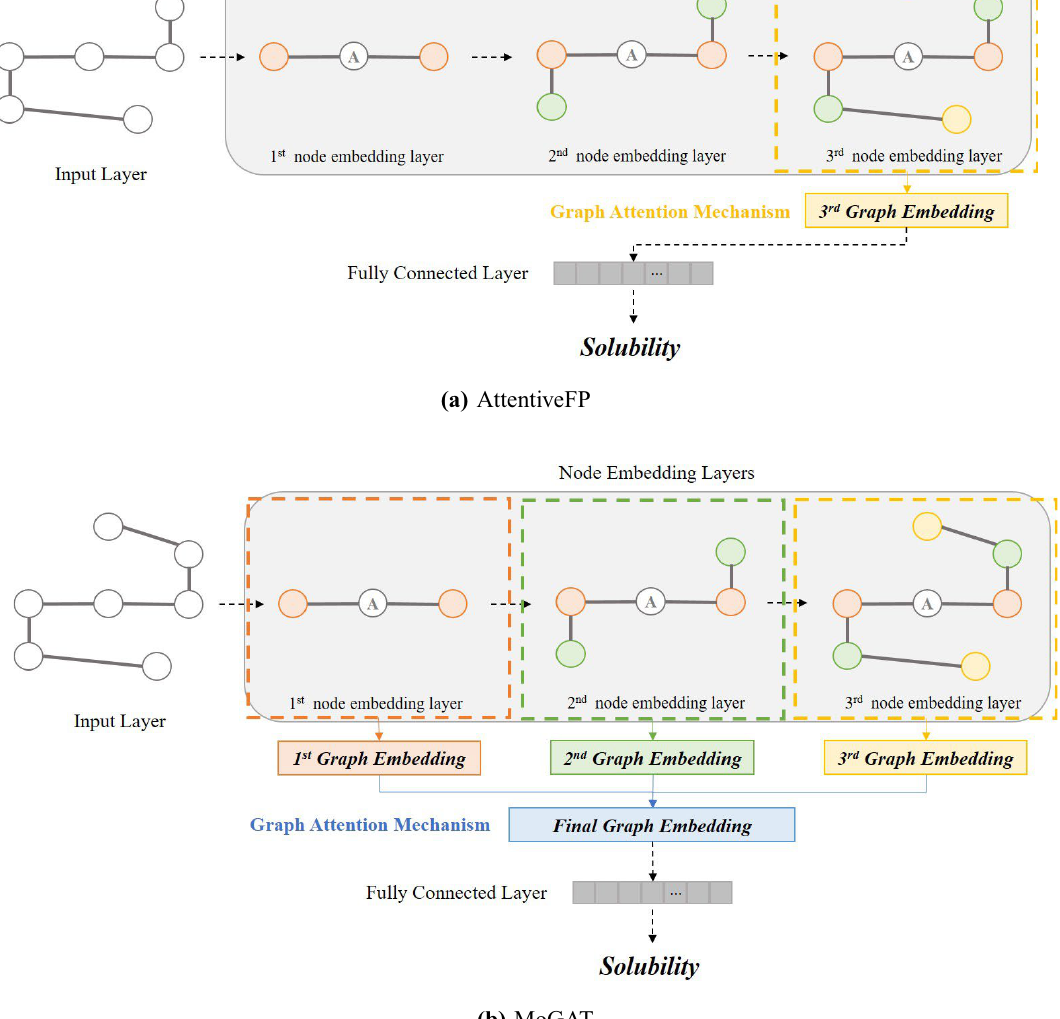
Figure 1. Overviews of ( a ) AttentiveFP and ( b ) MoGAT. The first, second, and third-order neighboring nodes are colored red, green, and yellow, respectively. In AttentiveFP, a graph embedding is obtained only from the final (third) node embedding layer. In contrast, MoGAT constructs graph embeddings corresponding to all node embedding layers, and the graph embeddings are combined into one final graph embedding (blue) via the attention